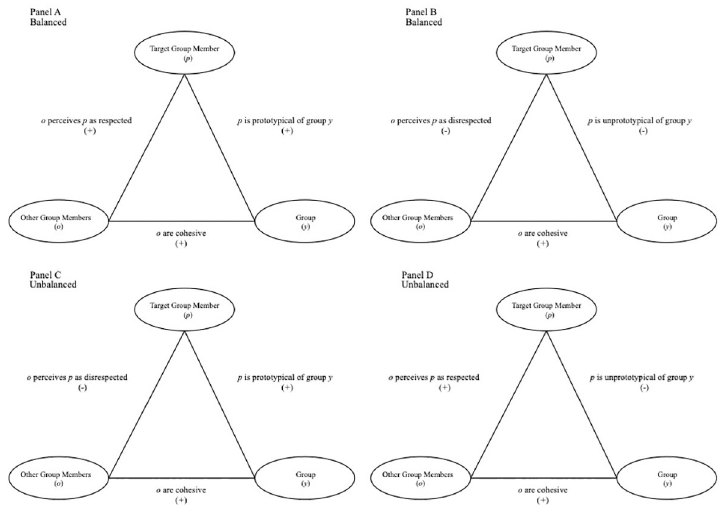
Fig 1. Balanced and imbalanced states under the condition of group cohesion. Panels A and B reflect states of balance. Panels C and D reflect states of imbalance. A “+” indicates a positive relation and a “-”indicates a negative